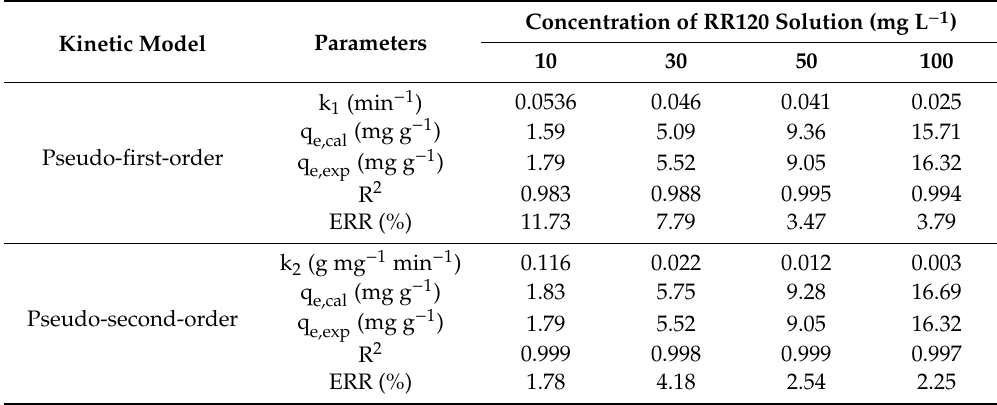
Table 4. Kinetic parameter for the adsorption of RR120 on the